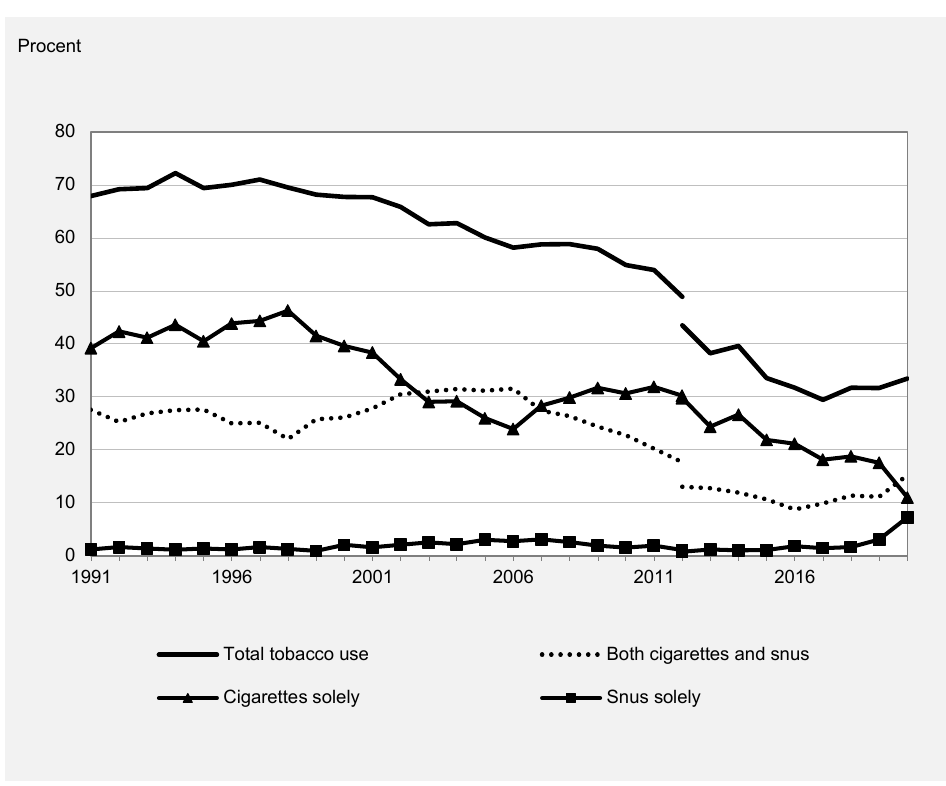
Figure 2. Use of tobacco among 15–16 ‐ year ‐ old males in Sweden, 1991–2020.